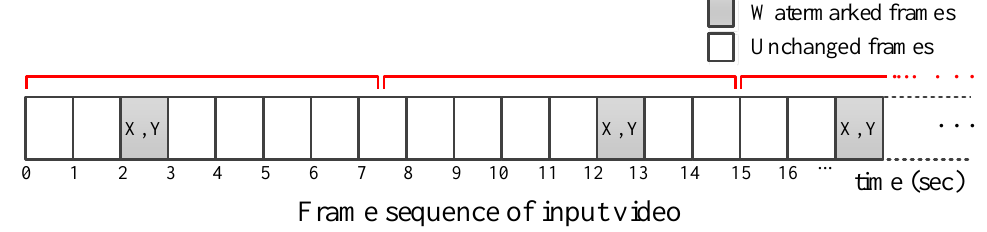
Figure 2. H.264 compression effect on correlation values as an extractor response (test sequence #2 from ITE/ARIB video).